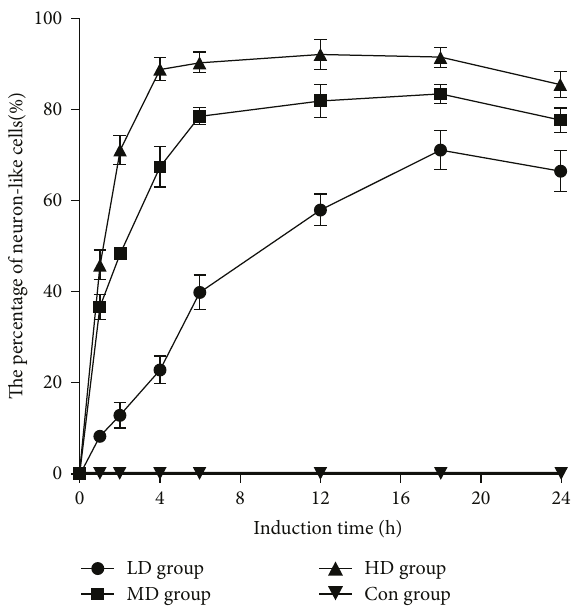
Figure 4: The percentage of neuron-like cells in each group was changed with the induction